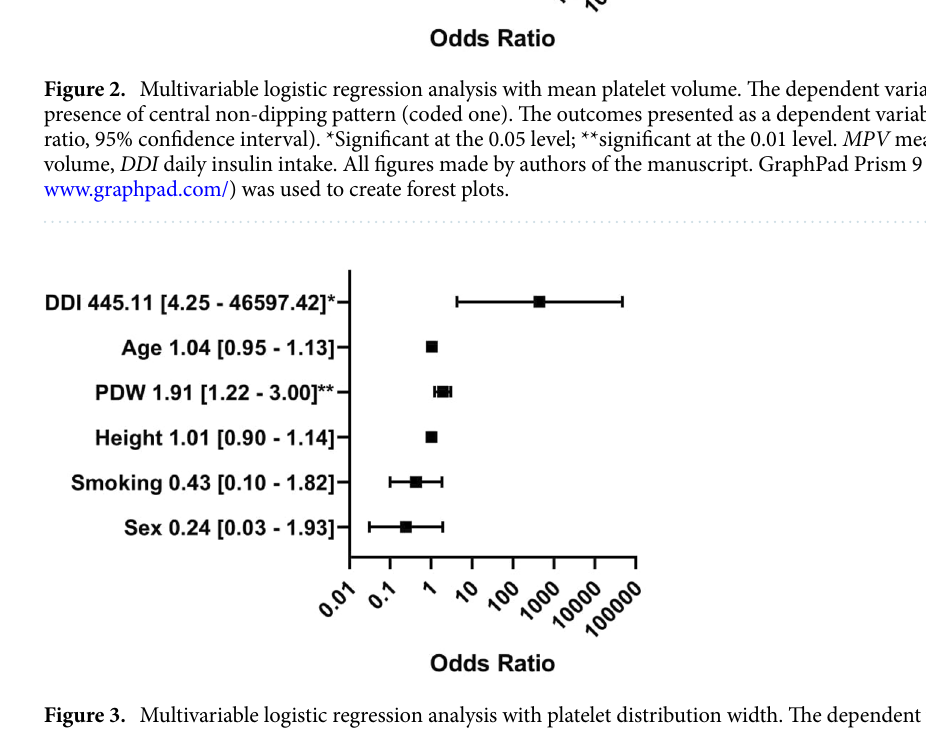
Figure 3. Multivariable logistic regression analysis with platelet distribution width. The dependent variable: the presence of central non-dipping pattern (coded one). The outcomes presented as a dependent variable (odds ratio, 95% confidence interval). *Significant at the 0.05 level. **Significant at the 0.01 level. PDW platelet distribution width, DDI daily insulin intake. All figures made by authors of the manuscript. GraphPad Prism 9 (https:// www. graph pad. com/) was used to create forest